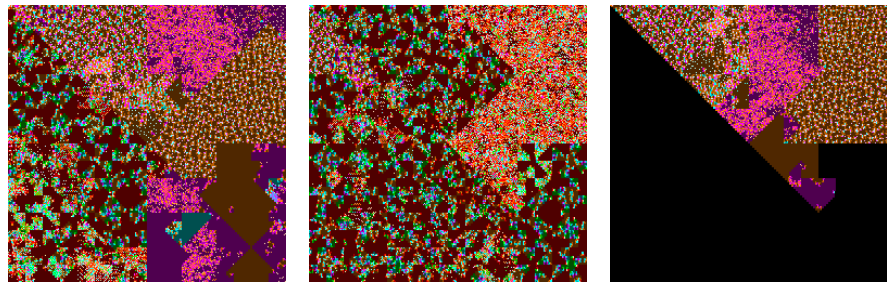
Figure 1. A 2D representation of a malicious .rtf file (159.71 KB) with the msword/cve20103333 Trojan.